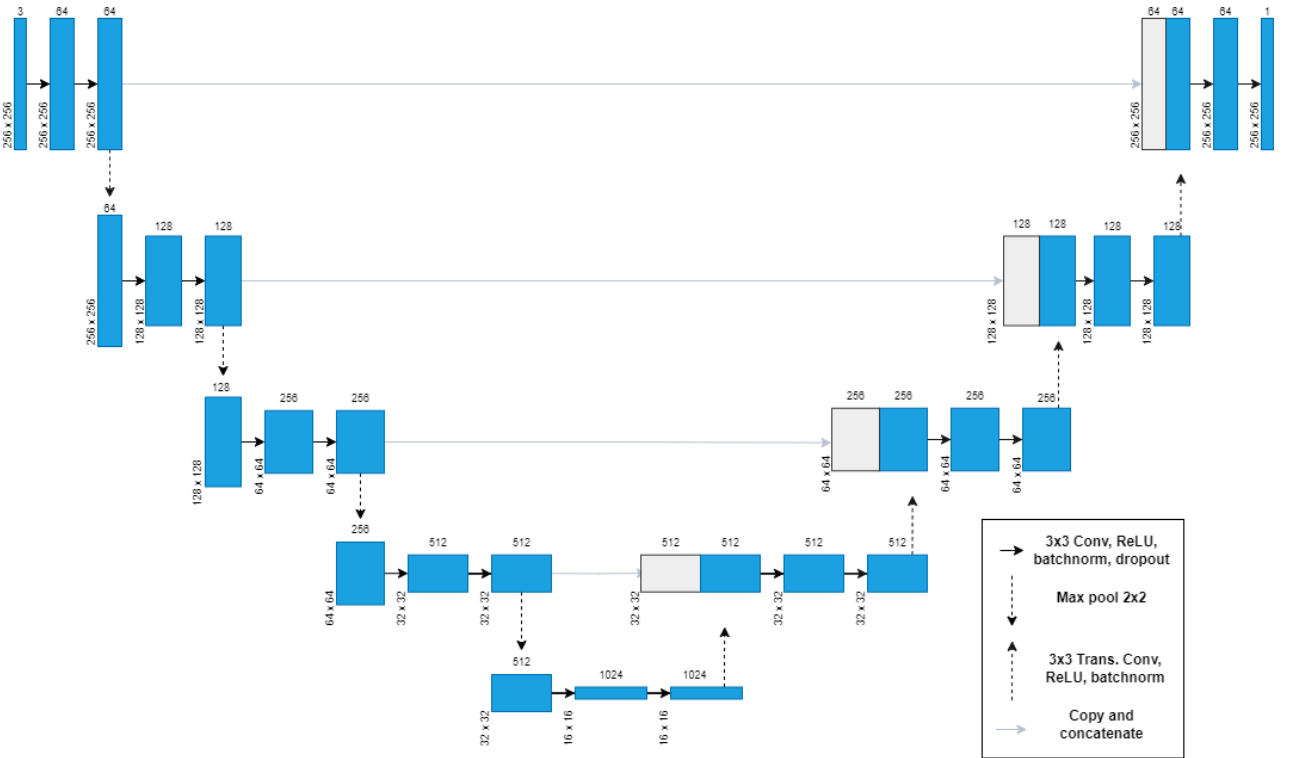
Figure 1. U-Net architecture (adapted from [19]).